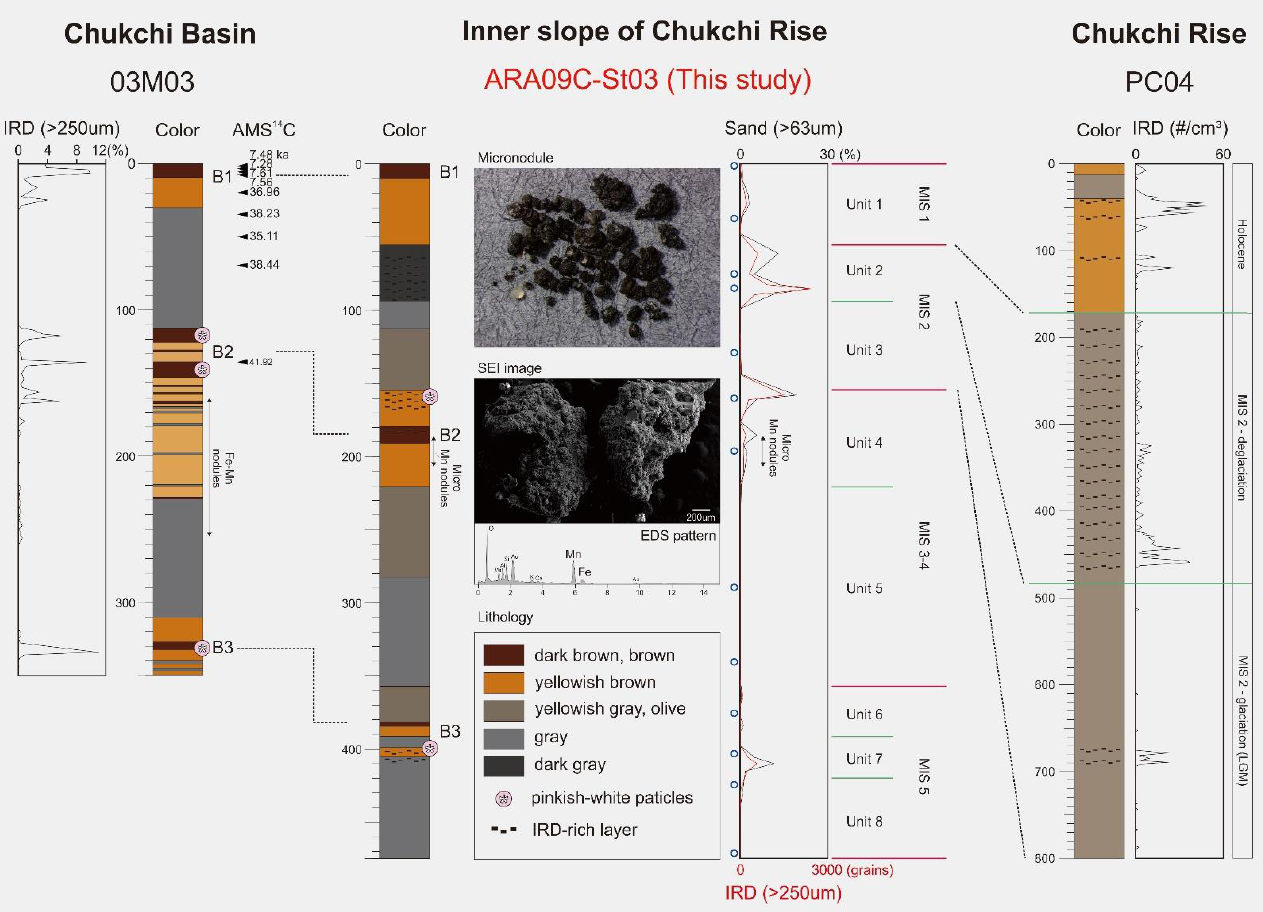
Figure 2. Vertical lithology profile of core ARA09C-St03, marked with color cycles, IRD contents, units, and marine isotope stages (MIS). Correlation of core 03M03 in the Chukchi Basin [23] and core PC04 in the Chukchi Rise [21] based upon color cycles, IRD contents. Micro Mn nodules for images and EDS pattern are taken from Unit 4 below the B2 in core ARA09C-St03. Blue circles at the left of the graph for IRD content in core ARA09C-St03 indicate the positions of subsamples to Nd isotope analyses.